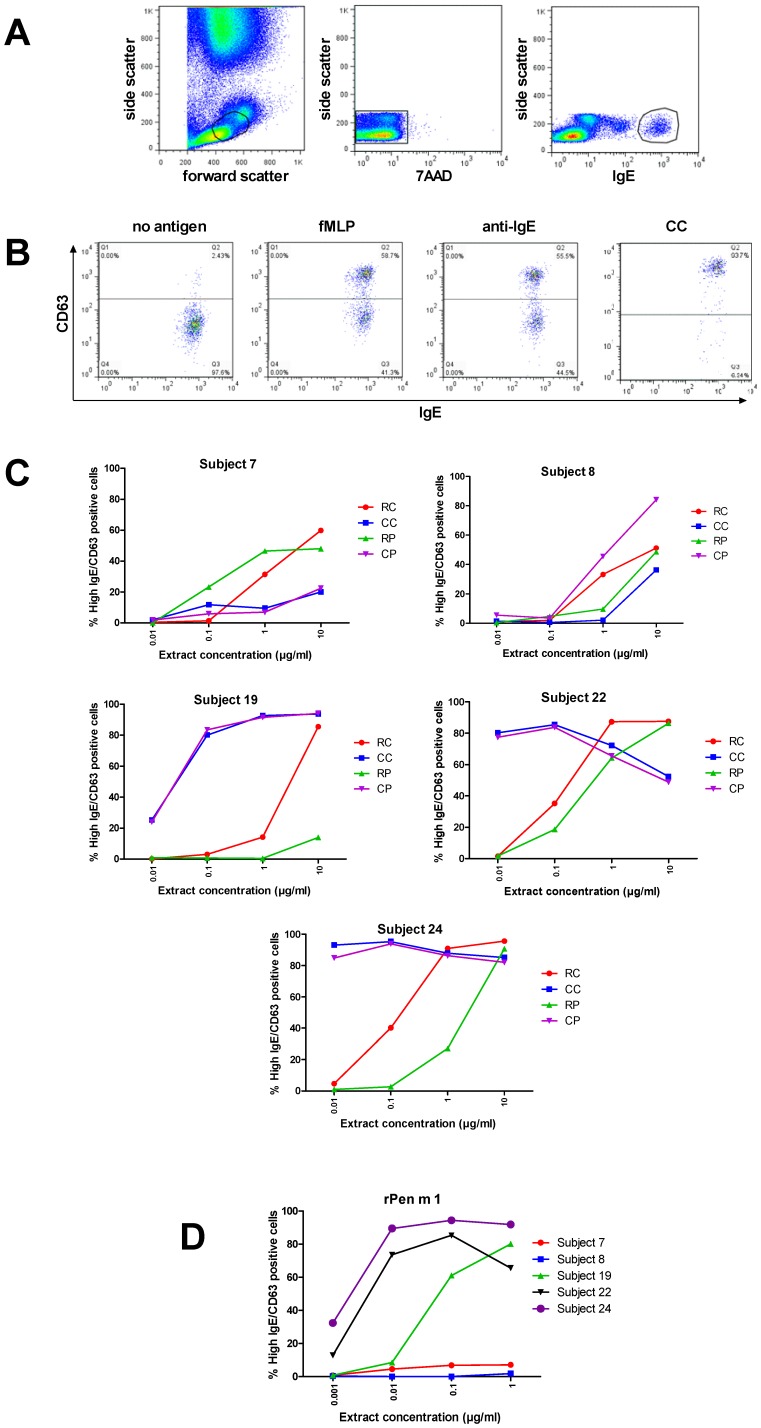

In vitro basophil activation by shellfish extracts and rPen m 1.
A. Representative dot plots showing gating of viable basophils (7AAD−, high IgE positive). B. Representative dot plots (subject 19) showing analysis of activated basophils (up-regulation of cell surface CD63) for negative and positive controls, and CC (10 µg/mL). C. Dose-dependent activation of basophils from shellfish-allergic subjects (7, 8, 19, 22, 24) by shellfish extracts. D. Dose-dependent activation of basophils from shellfish-allergic subjects (7, 8, 19, 22, 24) by rPen m 1.